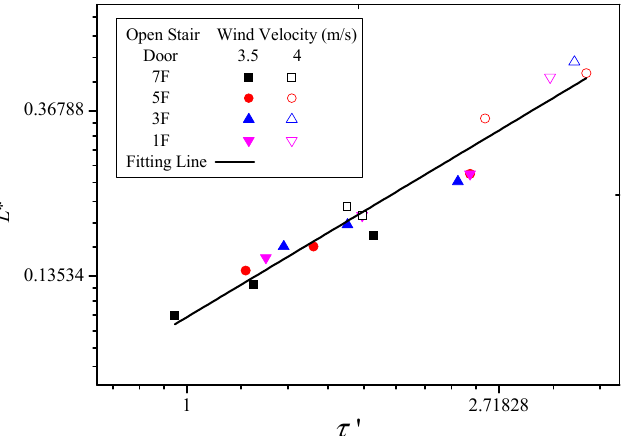
τ . τ . Figure 14. Dimensionless back-layering distance L * versus dimensionless back-layering time τ (cid:48)